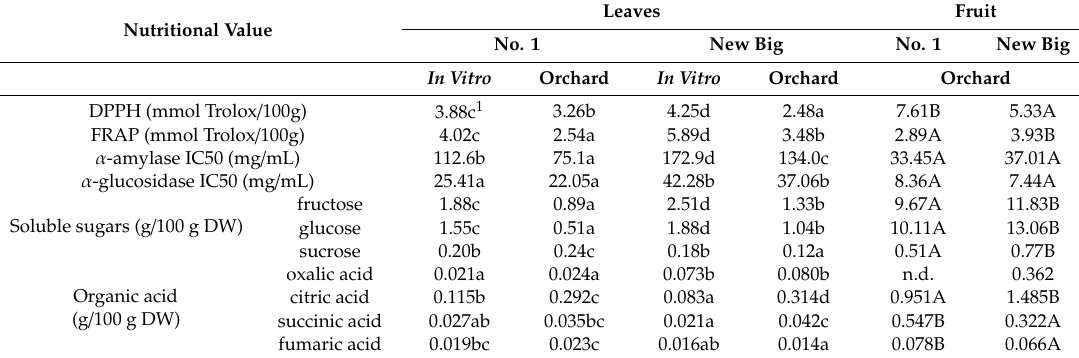
Table 5. Health-promoting capacities of leaves end fruit of two cultivars L. chinensis . Nutritional Value